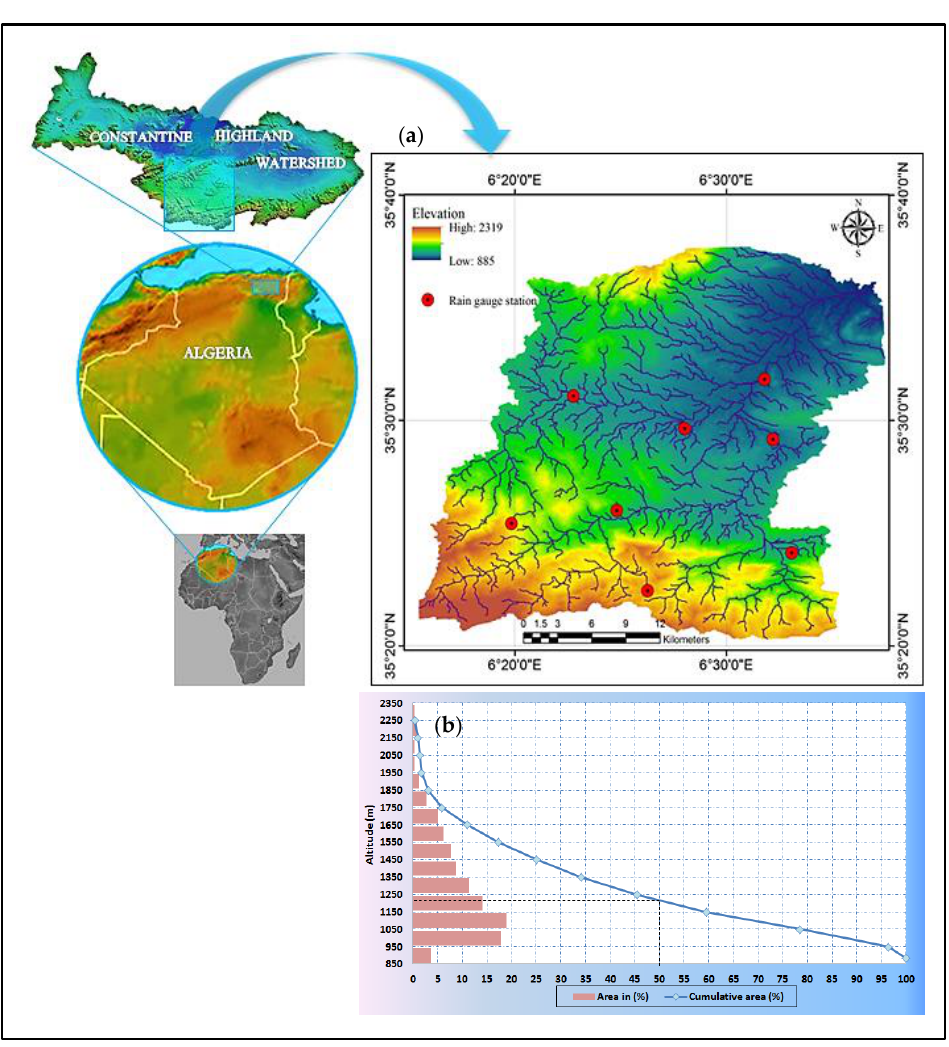
Figure 1. Map showing ( a ) the study area location and the rain gauge stations distribution and ( b ) the hypsometric curve of the Wadi Chemora